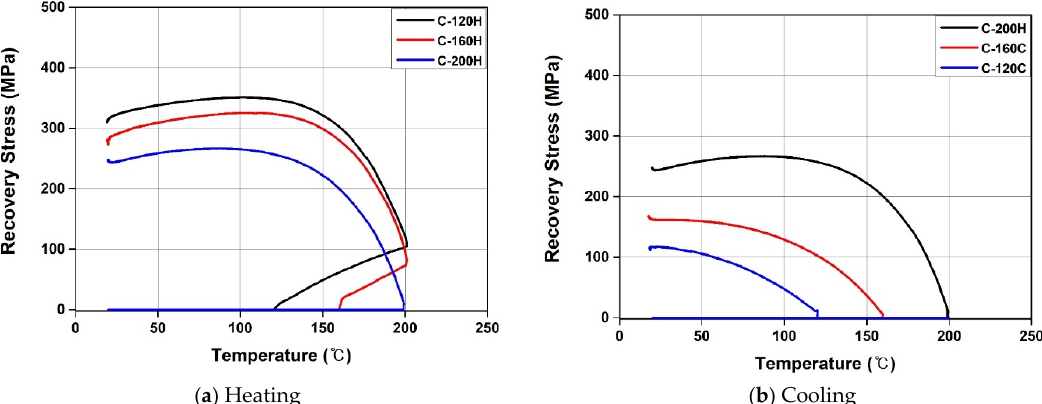
Figure 10. Comparison of FSMA ‐ A’s temperature ‐ recovery stress curves under partial restraint; ( a )